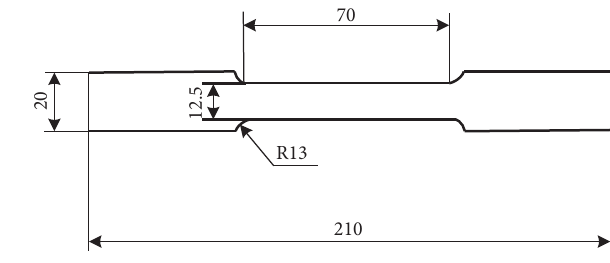
Figure 3: Dimension of the tensile test sample.